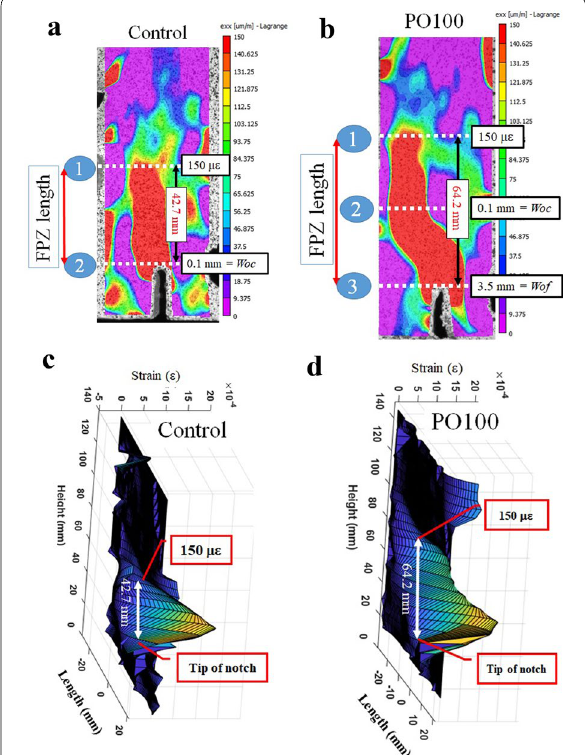
Fig. 17 FPZ measurement using strain profile at peak load point: a idealisation of FPZ, b control beam, c PO100 beam.